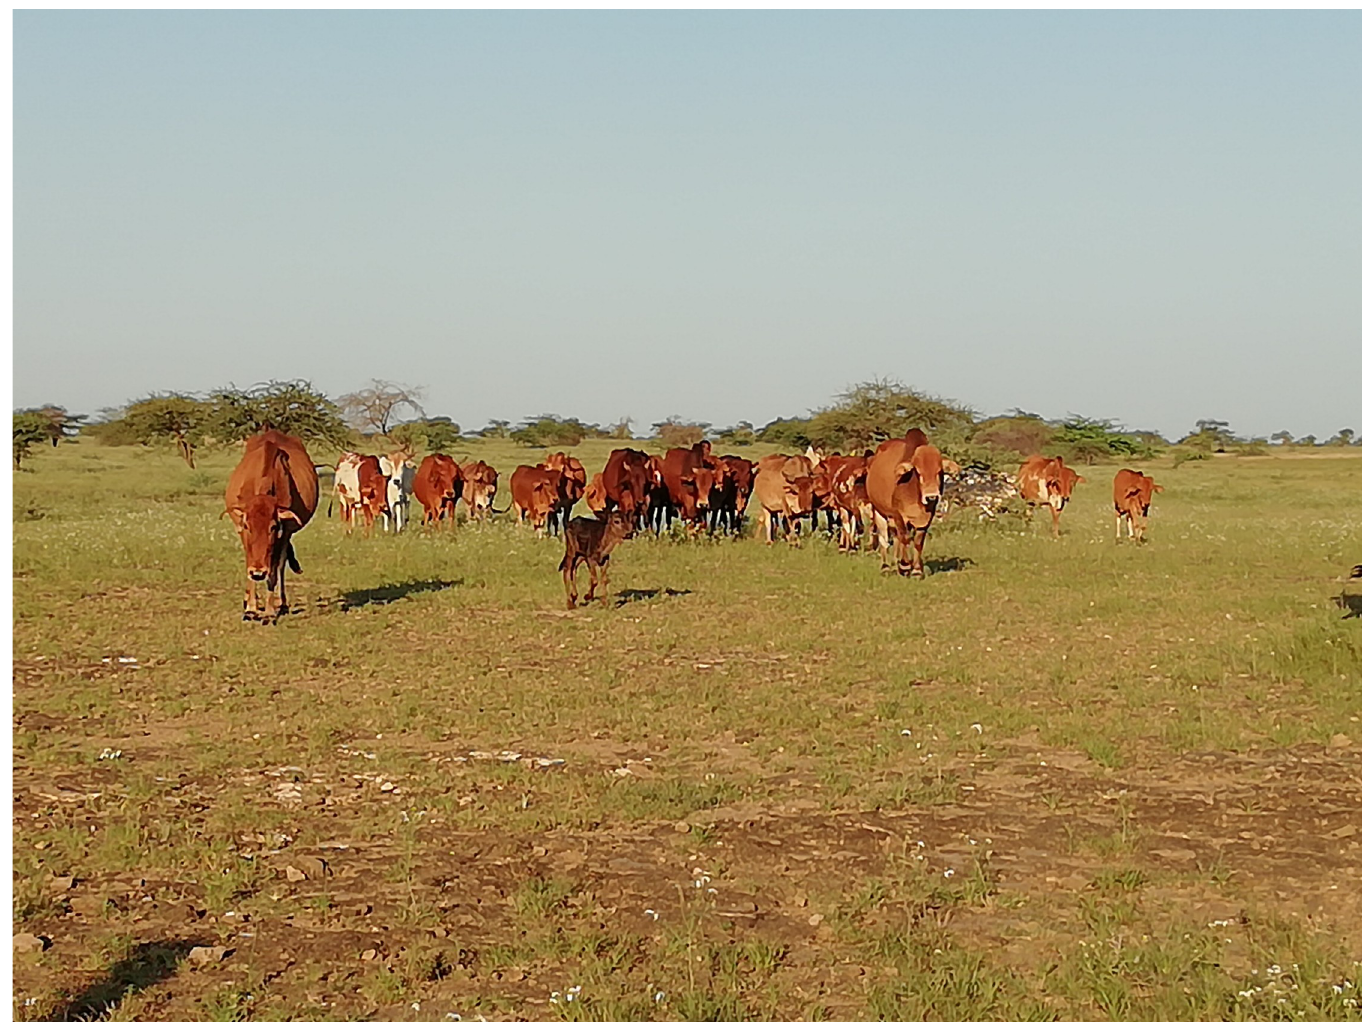
Fig 1. Cattle in rural Kenya. Photograph from February 2020 , taken by R . E . R . Nisbet .